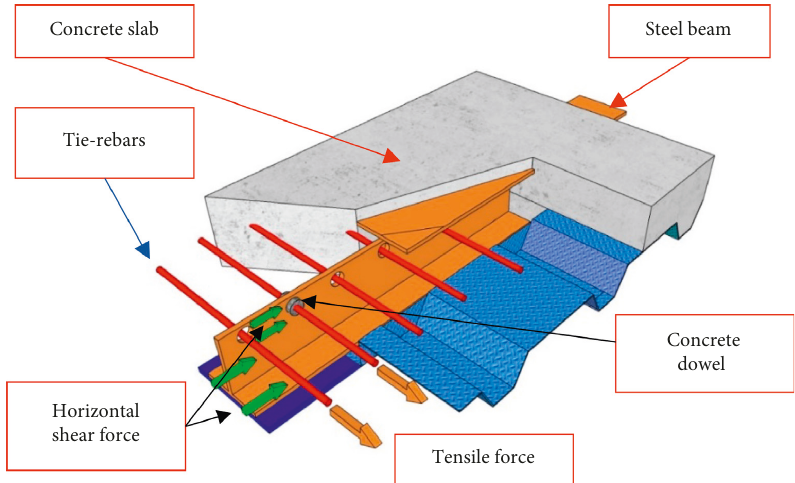
Figure 15: Composite slim floor beams with dowel shear